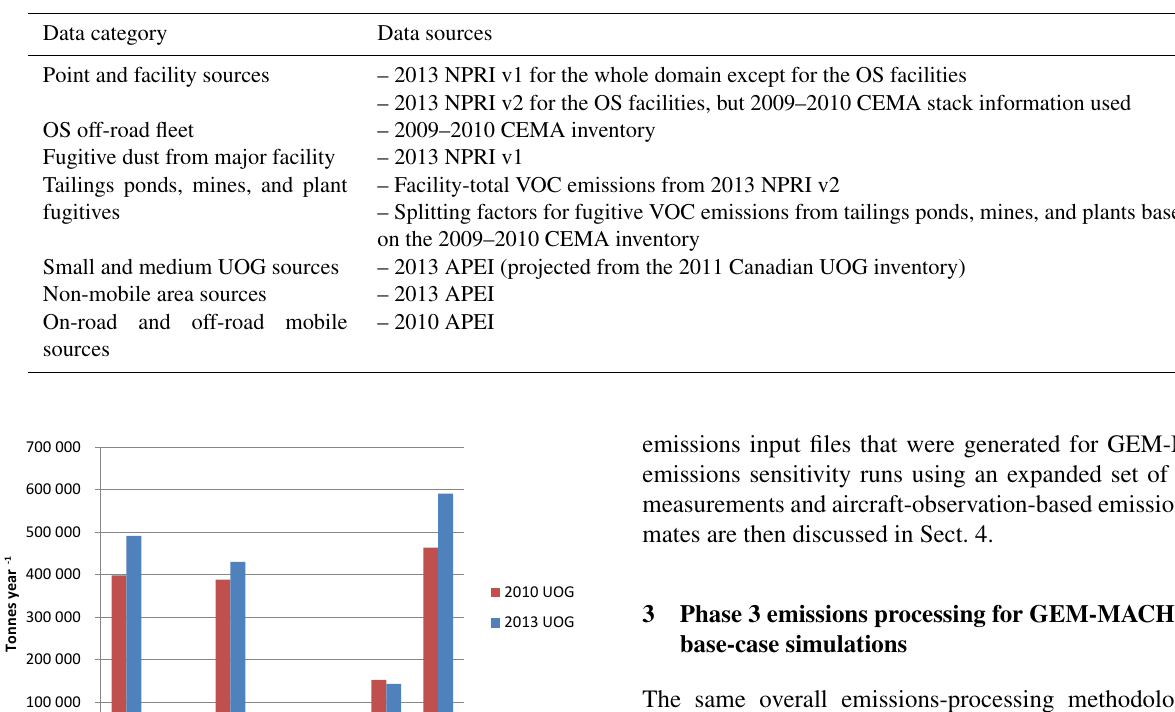
Table 2. Summary of Canadian data sources used for generating JOSM phase 3 base-case emissions input files.